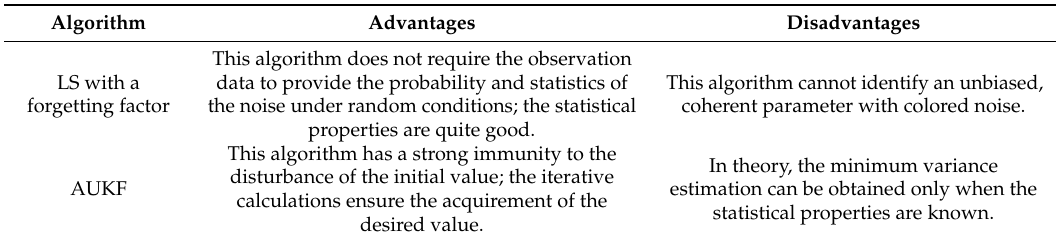
Table 1. The characteristics of the two algorithms.